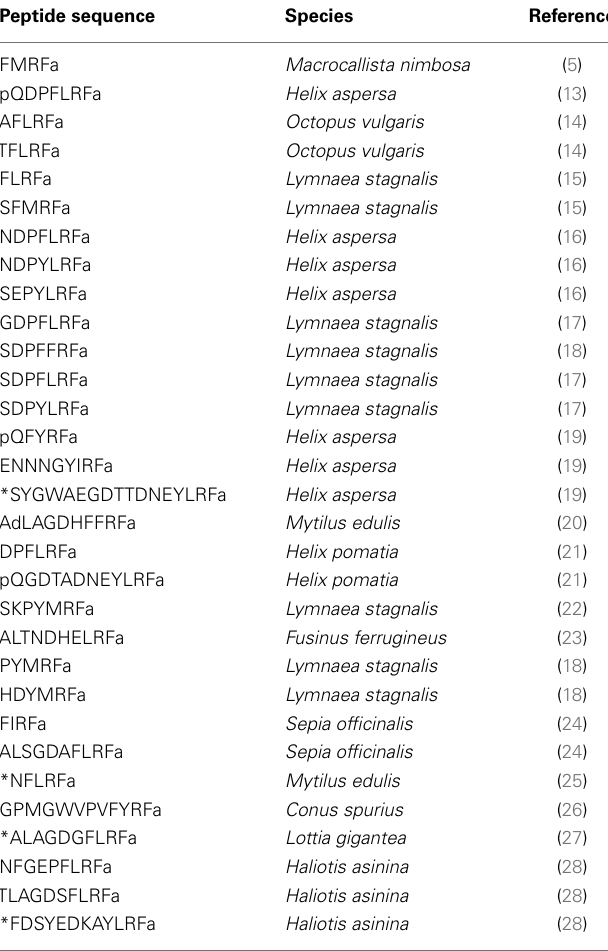
Table 1 | Diversity of FMRFamide-related peptides or FaRPs in mollusks